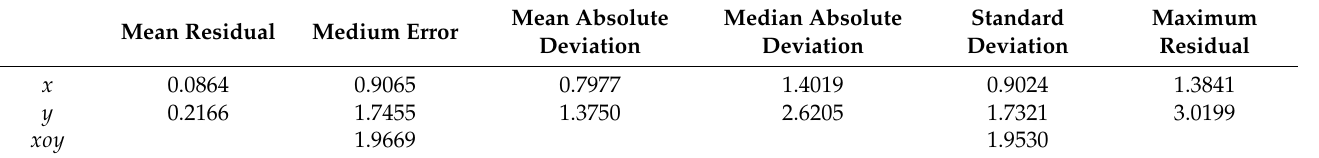
Table 6. The SIFT and RANSAC-based image registration accuracy—forest (units in meters).